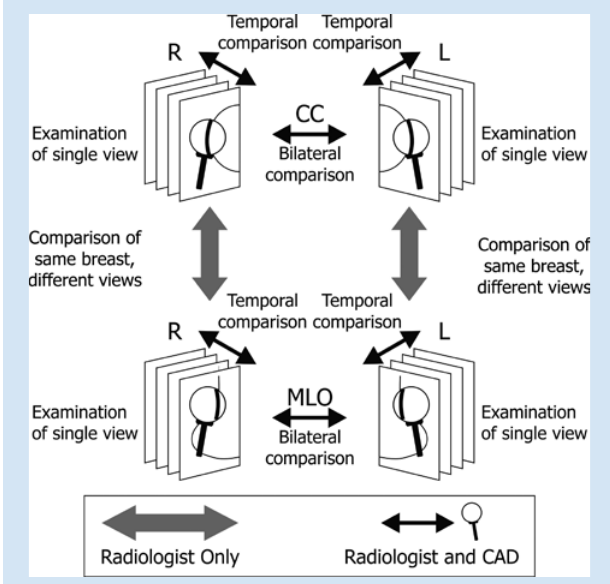
Fig. 1. Methods used by a radiologist to analyse a set of mammograms. Most methods have been implemented in a CAD system, but the examination of ipsilateral views has